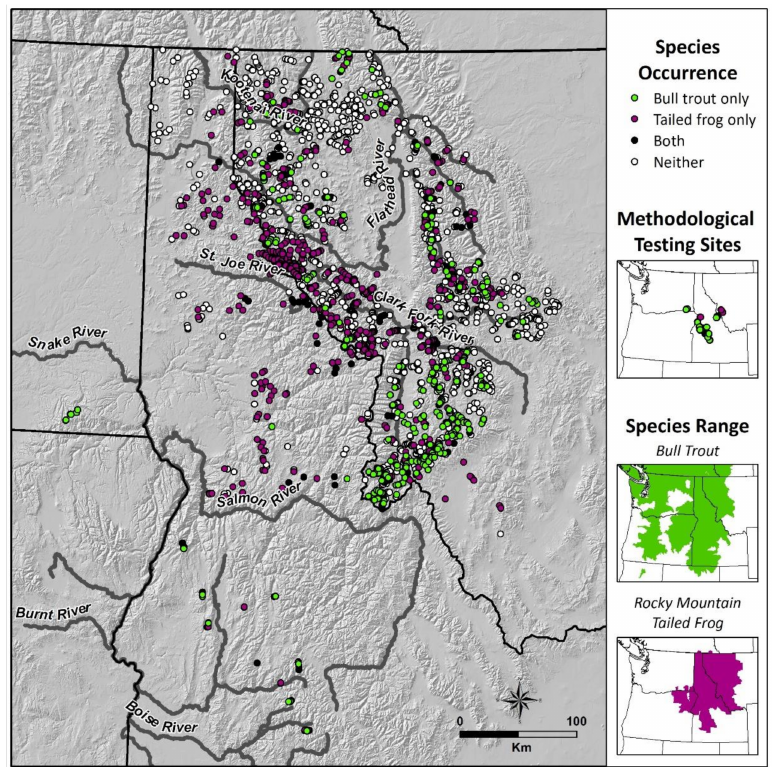
Figure 1. Map of the 2829 stream surveys used in this study. All surveys were conducted within the known range of the Rocky Mountain tailed frog ( Ascaphus montanus ) and bull trout ( Salvelinus confluentus ; see inset maps). Survey points represent 100-m reaches and are color coded based on the detection of each species during electrofishing surveys in 2006–2011. We conducted methodological tests on a smaller dataset of biological surveys conducted 1994–2002, shown in the top right